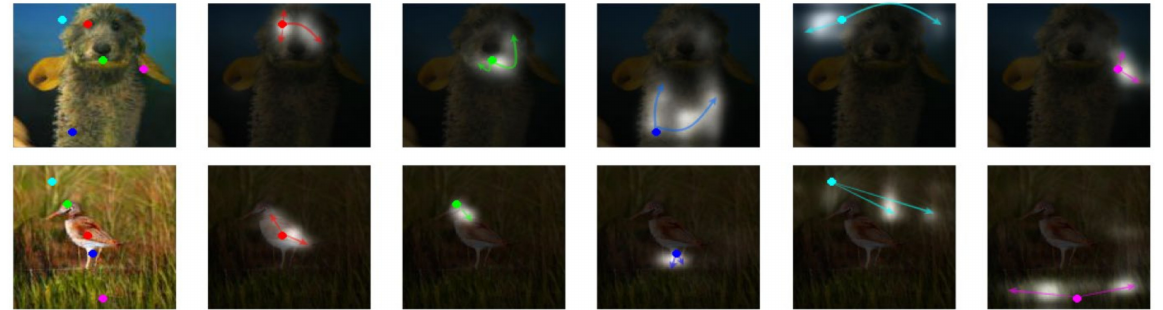
Figure 4. SAGAN generated image and its attention map [9].